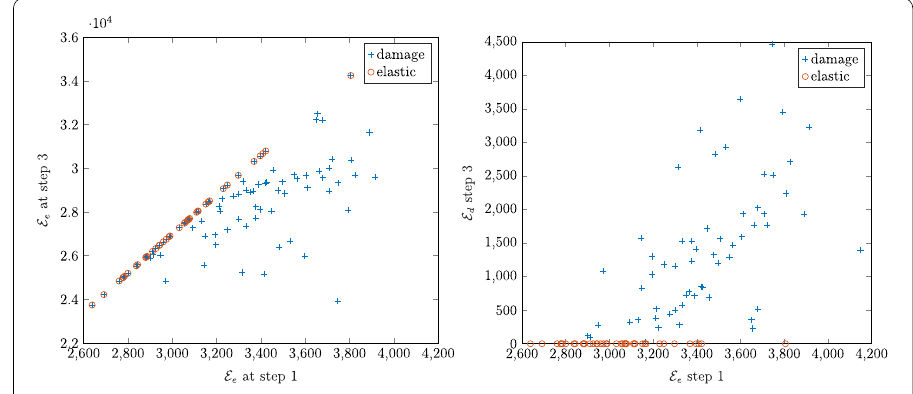
Fig. 10 Scatter plot of energies [J]: E e and E d between the linear elastic step 1 and the nonlinear step 3